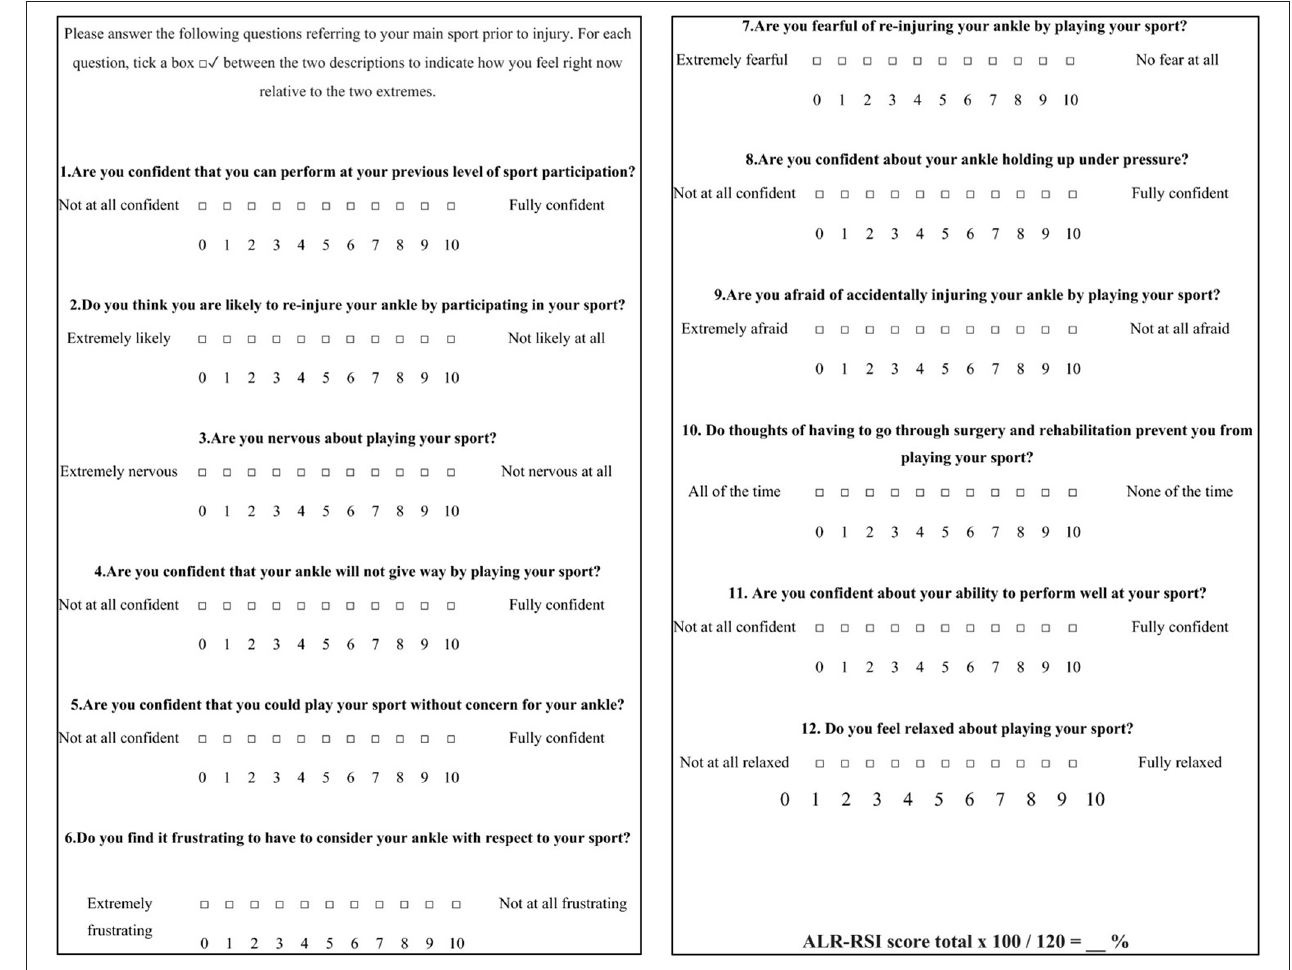
FIGURE 7 | Ankle ligament reconstruction-return to sport after injury (ALR-RSI).